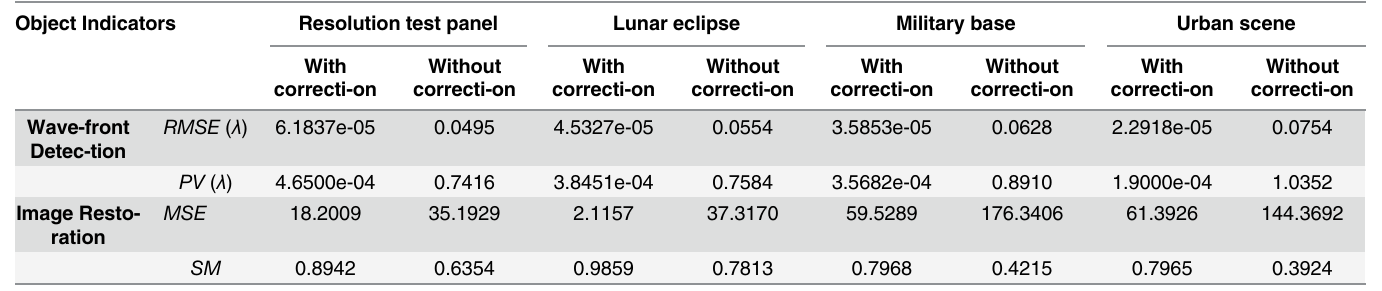
Table 3. Evaluation results of the wavefront detection accuracy and image restoration